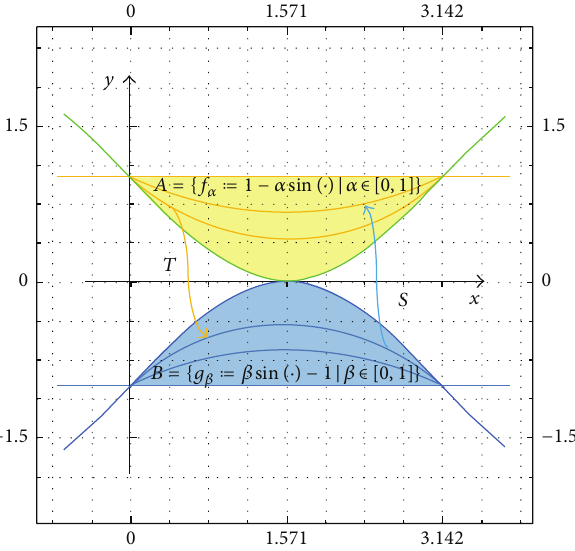
Figure 1: 𝐴 and 𝐵 in the function space (𝐶[0,𝜋],‖ ⋅ ‖ ∞ )